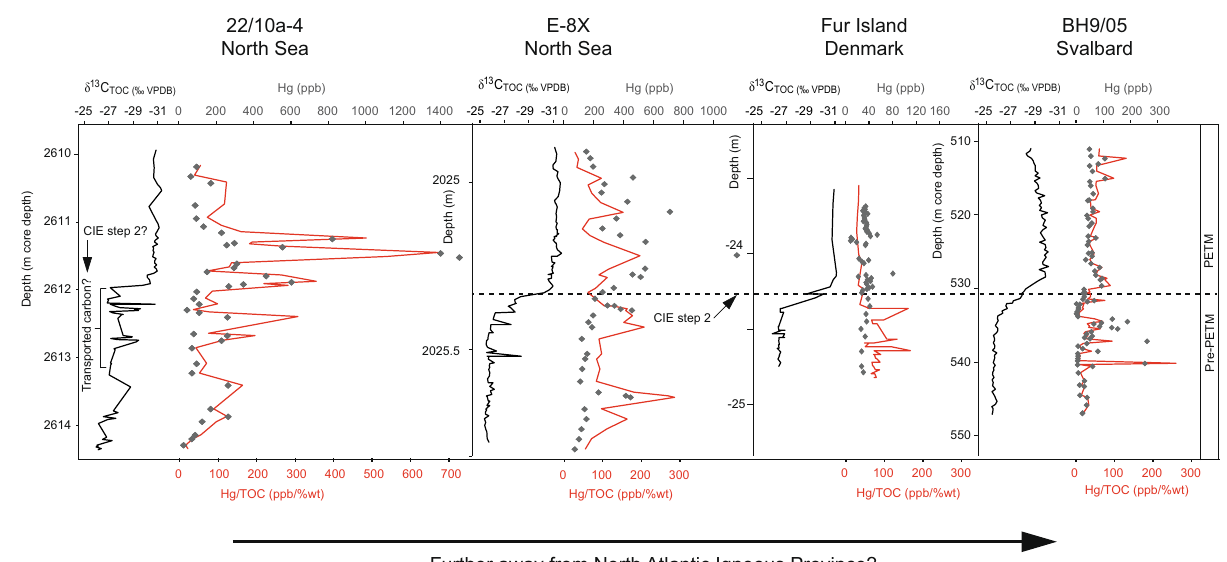
Fig. 5 Summary of Hg and Hg/total organic carbon (TOC) data from various sites at the onset of the PETM. North Sea well sites 22/10a − 4 and E − 8X (this study) generally display higher values than Fur and Svalbard 7 . Carbon isotope excursion (CIE) step 2 is shown as a dashed line and does not co-occur with a Hg or Hg/TOC spike in the sections. Core 22/10a − 4 has previously been interpreted to have been partially impacted by transported carbon 26 . Bulk sediment δ 13 C TOC is reported as ‰ VPDB, Vienna PeeDee